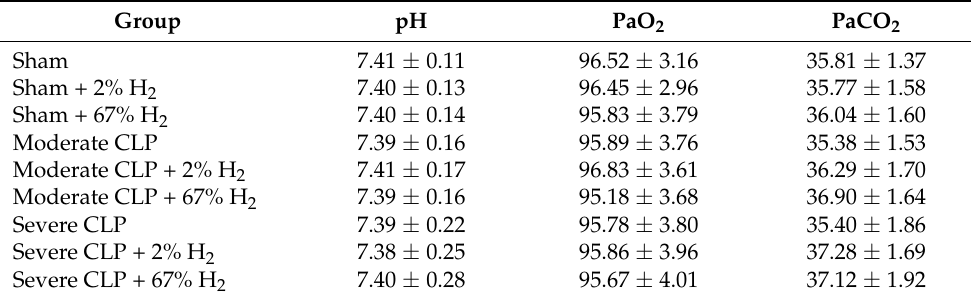
Table 1. Arterial blood gas of mice in each group after inhalation of 2% and 67% hydrogen. Group pH PaO 2 PaCO 2 Sham